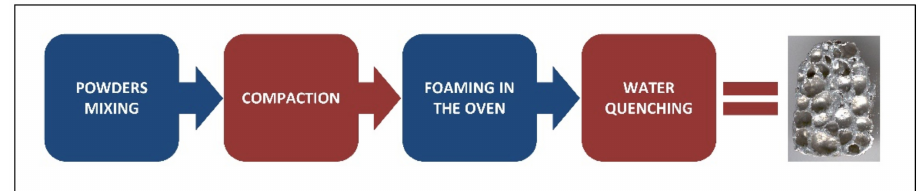
Figure 1. Flow chart of compacted powder